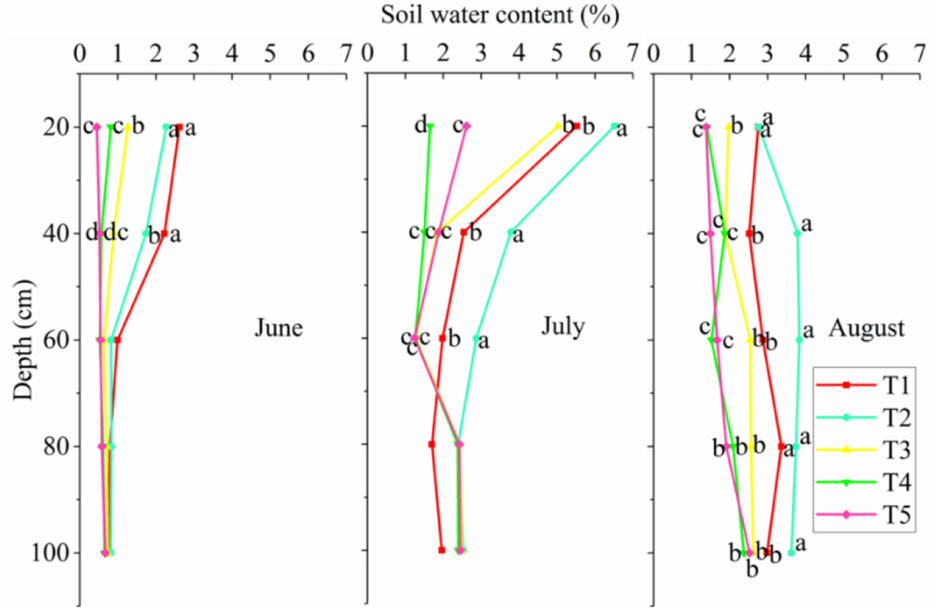
Figure 3. Gravimetric soil water content in the different soil depths was measured in June, July and August. The different letters within a depth layer denote significant differences ( p < 0.05) among the five population densities. The standard error of the mean for June, July and August soil water content were 0.12, 0.15 and 0.26,